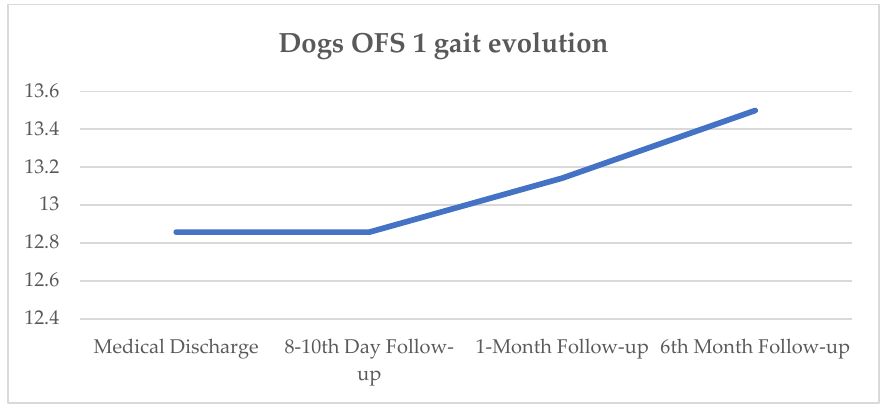
Figure 7. Dogs’ OFS gait evolution since medical discharge and follow-up (8–10-day, 1-month, and 6-month); OFS—open field score described by the y-axis [64].